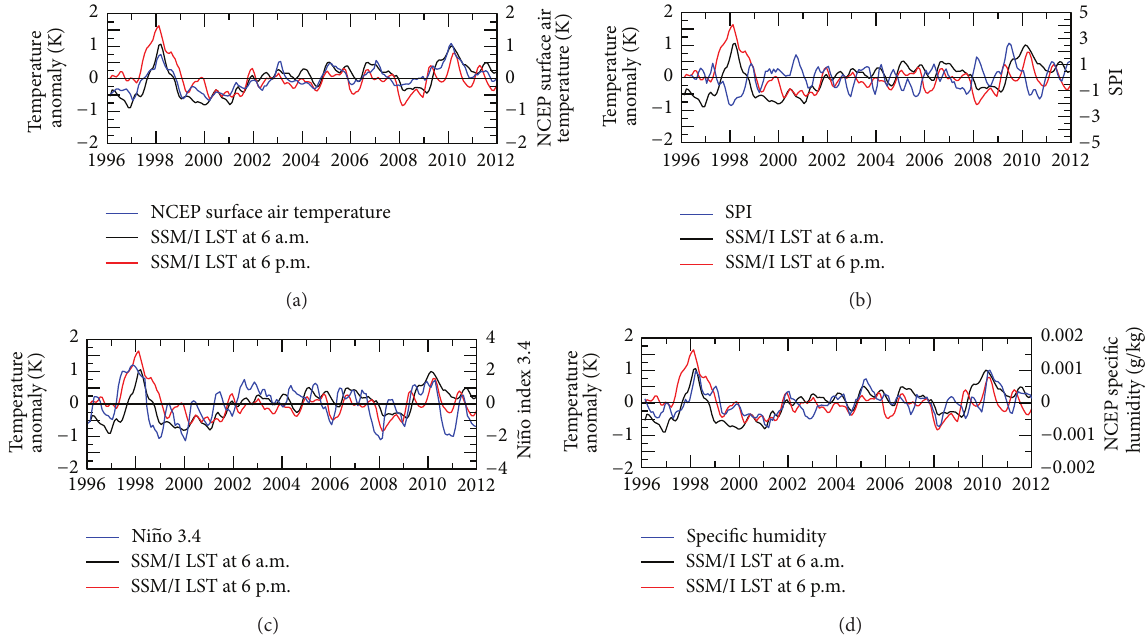
Figure 2: Comparison between time series of the domain averaged temperature anomalies of remotely sensed LST (at 6 a.m. and 6 p.m.) over Amazon rainforests with the following: (a) NCEP surface air temperature, (b) SPI, (c) Ni˜no 3.4 index, and (d) NCEP specific